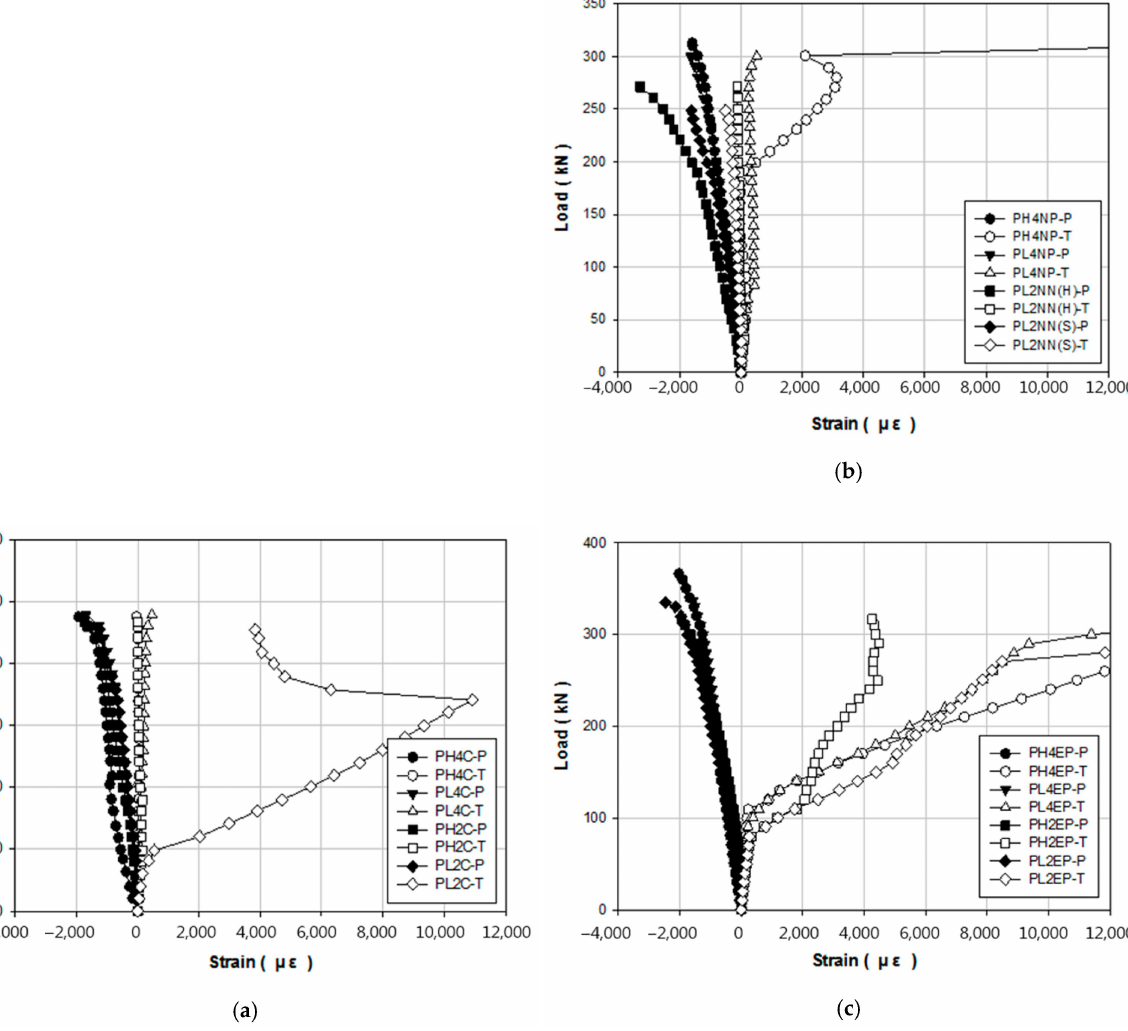
Figure 11. Concrete load–strain responses for different strengthening methods: ( a ) PSC (control), ( b ) NSM, and ( c )